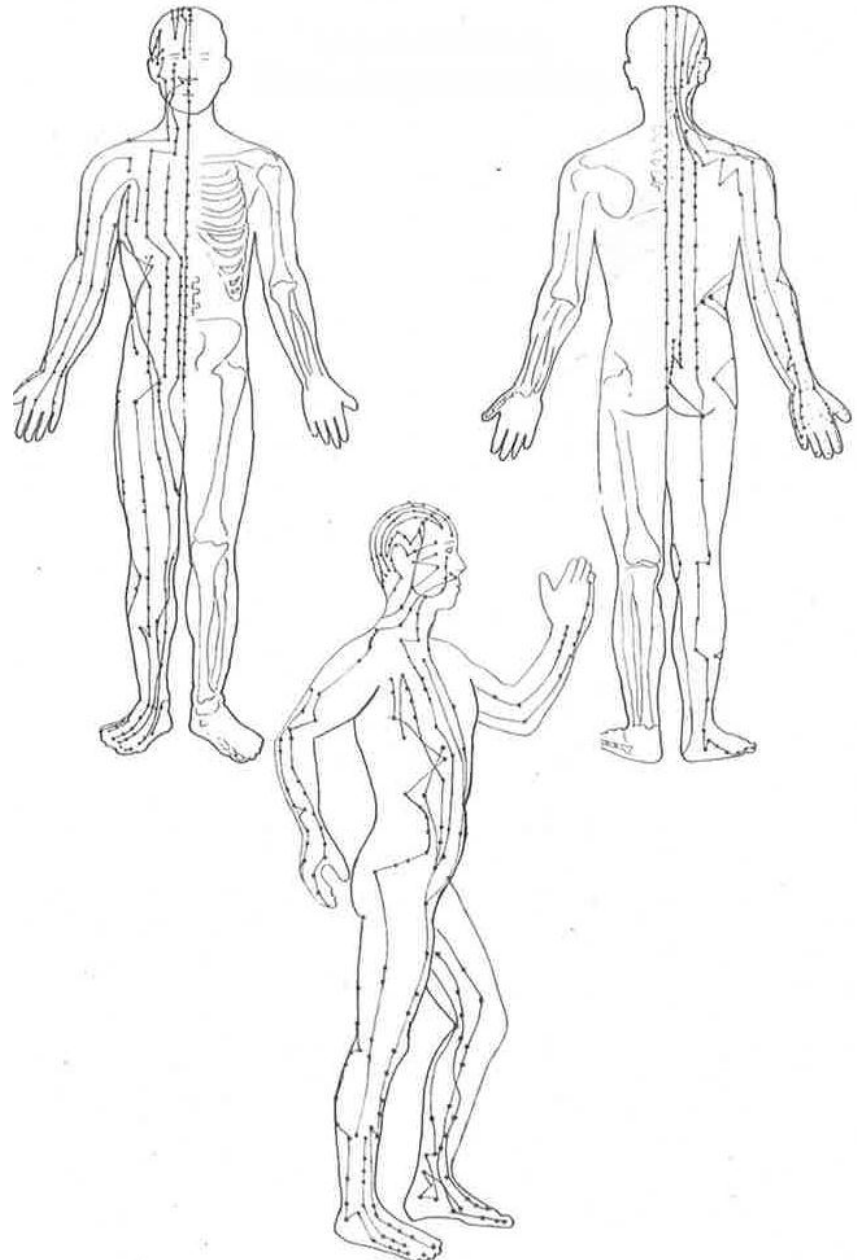
Figure 1. Meridians (lines); Acupuncutre points (dots) from the 12 major meridians. (Reproduced with permission from Picard, G. Heal Yourself with Qigong . Spiral Graphics: Canada; 2009; p. 47).